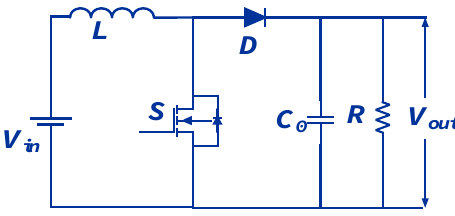
Figure 5. Configuration of Boost converter.